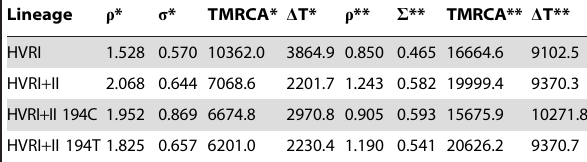
Table 3. r -statistics and TMRCA estimates for various root lineages, using lineages present only in South